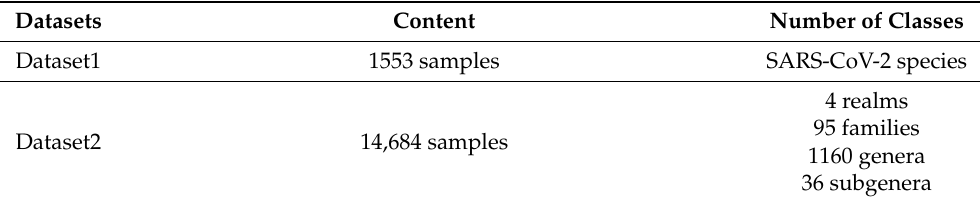
Table 1. Contents of datasets used in this